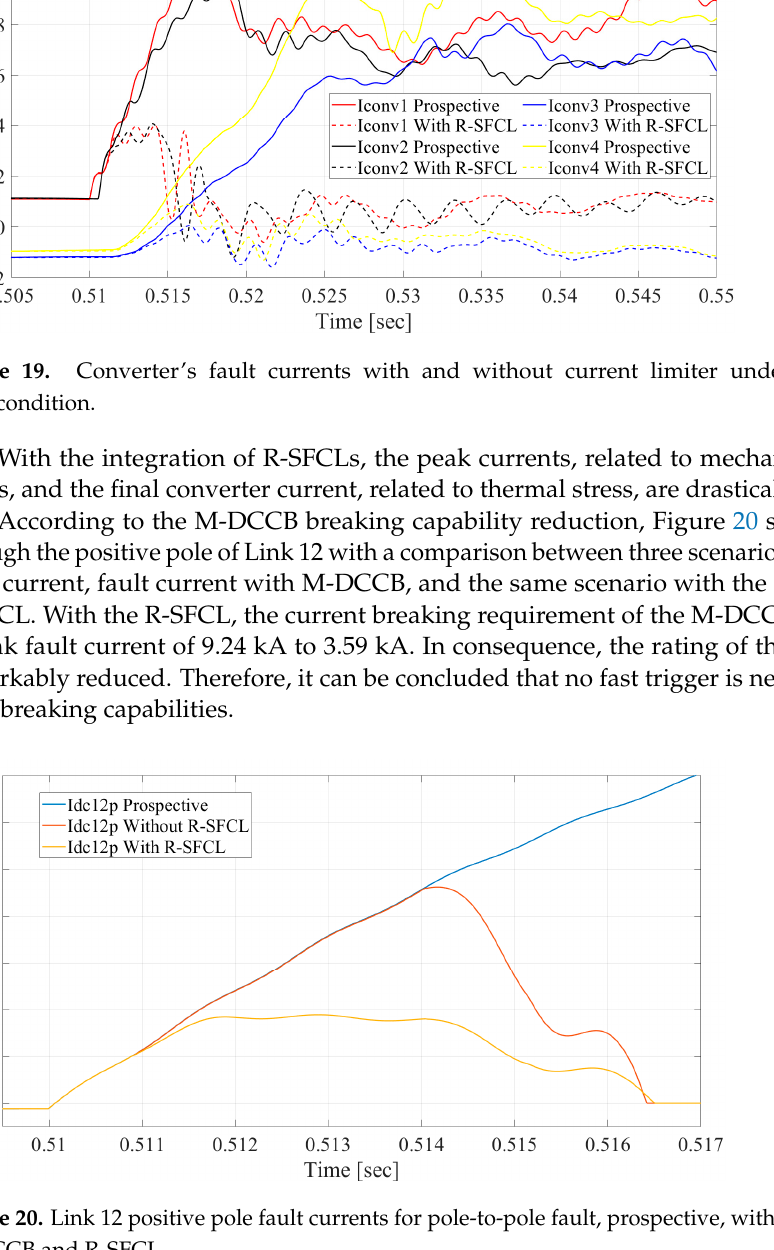
Figure 19. Converter’s fault currents with and without current limiter under pole-to-pole fault con- dition. Table 5. Peak current and limiting factor comparison for pole-to-pole fault.